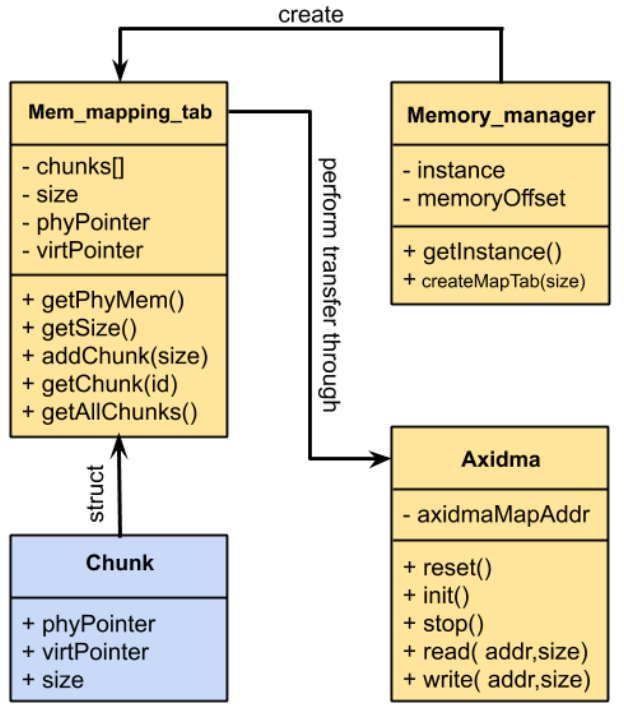
Figure 3. API classes and relational diagram. Orange elements represent C++ classes and the blue element represents a C++